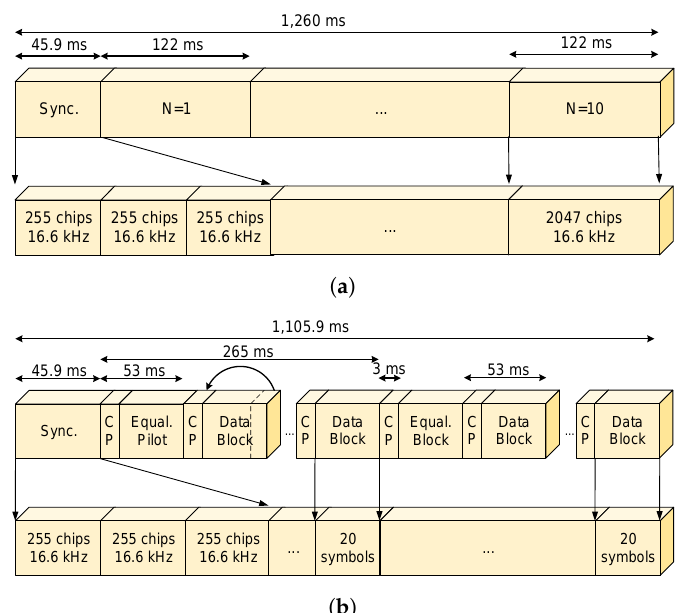
Figure 13. ( a ) High robustness data frame definition and ( b ) high throughput data frame